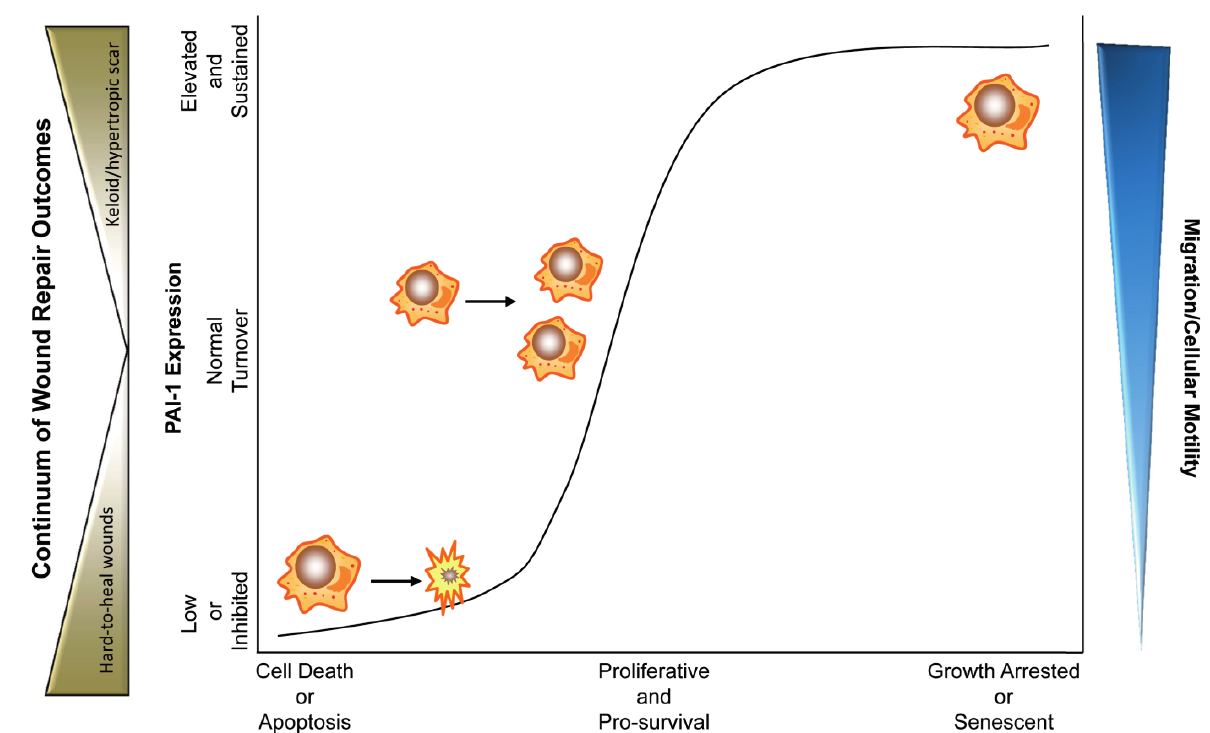
Figure 2. PAI-1 levels and activity dictate cellular rheostasis and during physiological and pathophysiological wound healing. In this triaxial model, moderate expression of PAI-1 where PAI-1 is under constant homeostatic turnover, promotes a physiological pro-proliferative, pro-survival and pro-migratory phenotype. Upon tissue injury, cytokines (e.g., TGF- β and EGF) stimulate PAI-1 expression promoting wound closure. During final stages of wound repair, PAI-1 levels drop, halting the pro-repair processes (e.g., by increased myofibroblast apoptosis and reduced keratinocyte motility) finalizing proper injury resolution. Chronically low expression or inhibition of PAI-1 activity abrogates cellular migration and motility while stimulating cellular death (predominantly apoptosis). Ulcerations and hard-to-heal diabetic wounds might represent such wounds where reduced re-epithelialization and myofibroblast contractility, as a result of inhibited migration and premature apoptosis, contribute to insufficient wound closure. Pathologically elevated and/or sustained PAI-1 levels, in contrast, may promote a growth-arrested, pro-migratory pathophysiological phenotype (e.g., keloids, fibrosis) where dermatological hypercontractility is a result of persistence of wound bed myofibroblasts with continued extracellular matrix deposition and remodeling. In some instances, sustained PAI-1 expression, particularly in the context of p53 modulation, may activate a cellular senescence program [36]. In either pathological scenario, elevated (hypertrophic scar, keloid) or low (hard-to-heal chronic wounds) PAI-1 expression by genetic ablation/small-molecule antagonism or recombinant amplification, respectively, may constitute attractive therapeutic